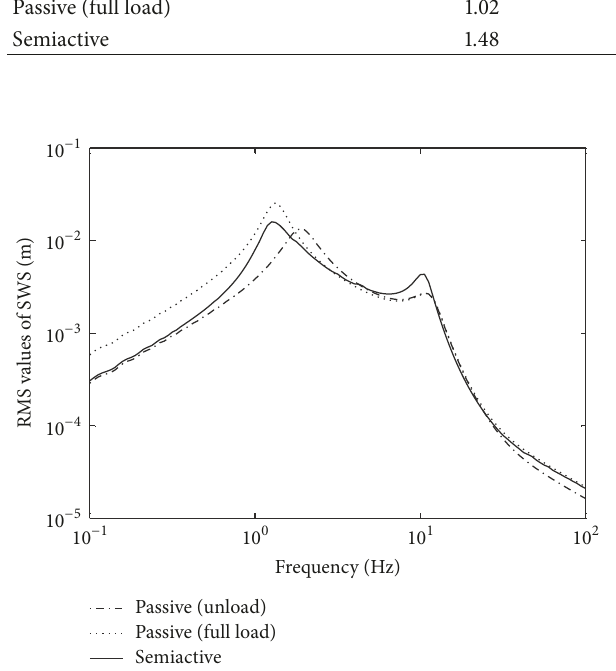
Figure 6: Frequency responses of suspension working space.